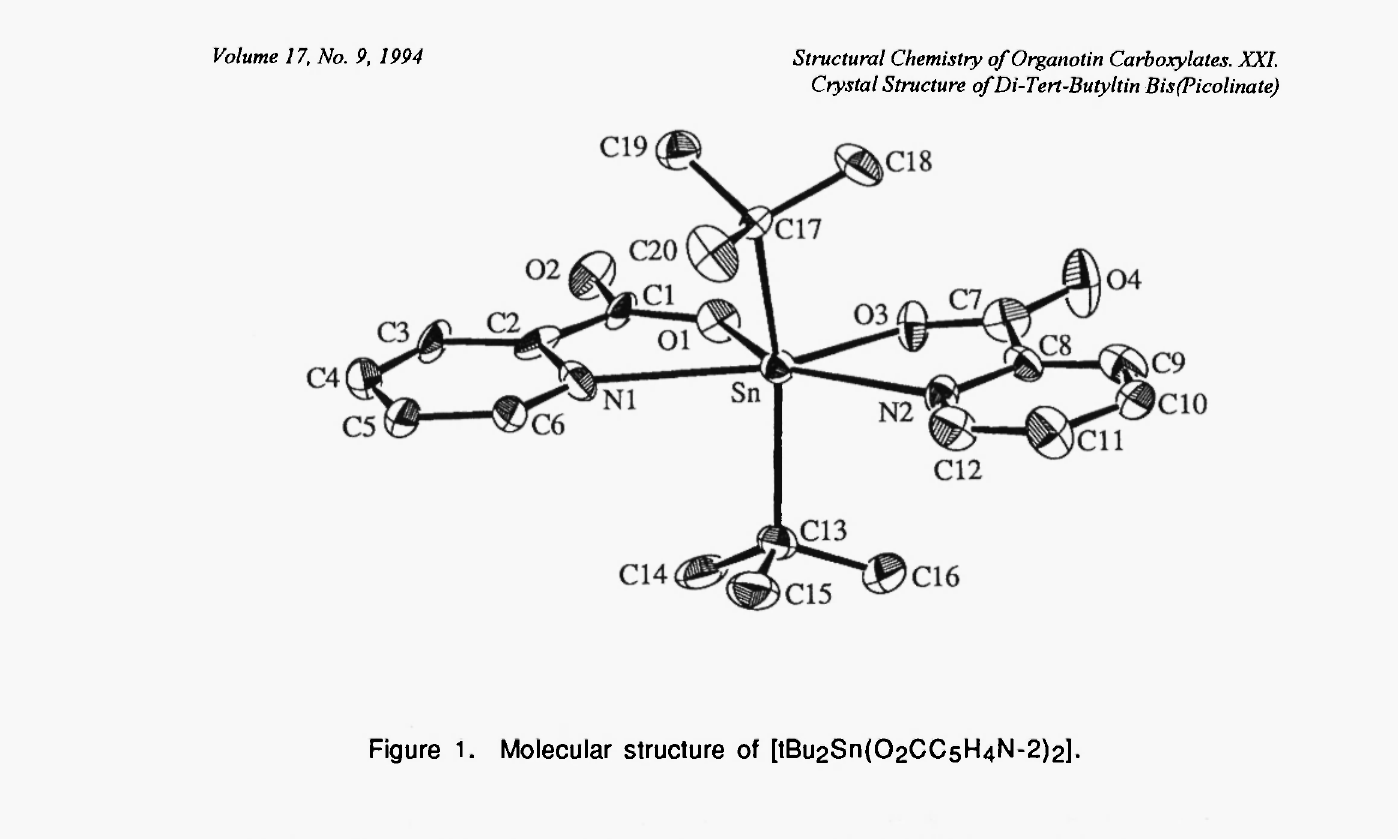
Table 2. Selected bond distances (A) and angles (°) for